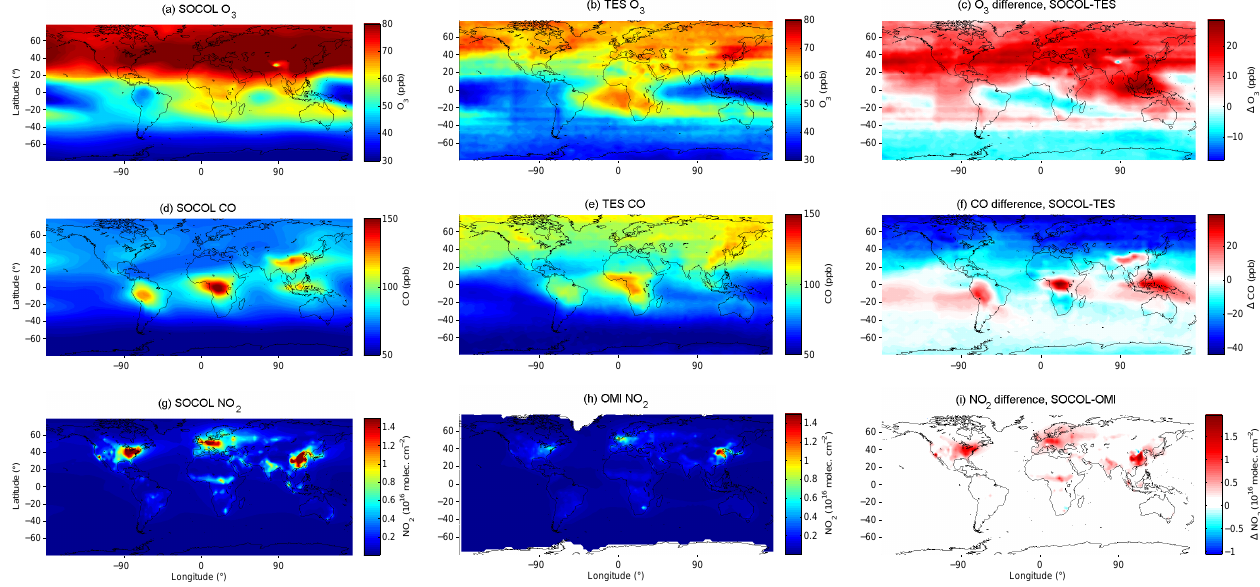
Figure 2. Comparisons of SOCOL model results (from the REF-C2 simulation) with observations, averaged over 2005–2009, for: (a) SOCOL ozone, 500hPa; (b) TES ozone, 464hPa; (c) ozone difference (panel (a) minus (b) ); (d) SOCOL CO, 500hPa; (e) TES CO, 464hPa; (f) CO difference (panel d minus e ); (g) SOCOL tropospheric column NO 2 ; (h) OMI tropospheric column NO 2 ; (i) NO 2 difference (panel g minus h